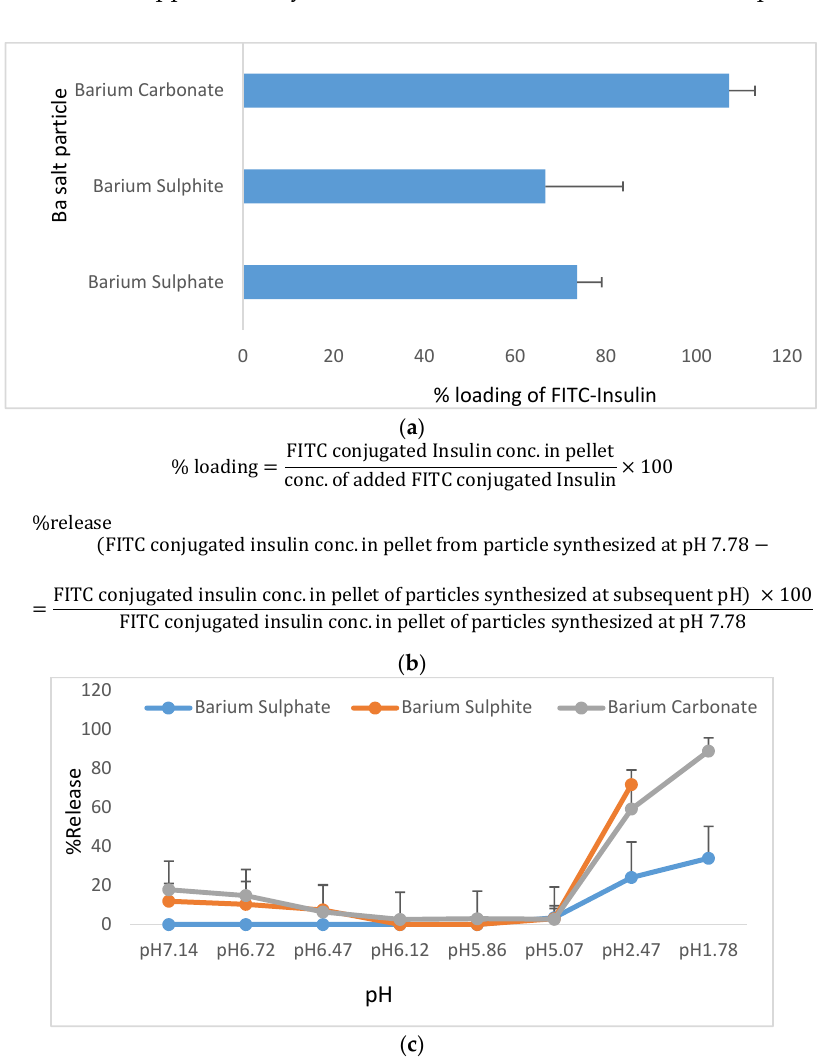
Figure 6. Measurement of insulin binding affinity towards Ba salt particles. The efficiency of FITC-insulin association with the particles (%loading) at pH 7.78 and subsequent release (%release) of FITC-insulin after exposure of the insulin-particle complexes to a range of pHs were calculated from fluorescein intensity of FITC-insulin loaded into Ba salt particle. ( a ) Shows % loading of FITC-insulin into Ba salt particle (BaSO 4 , BaSO 3, and BaCO 3 ). ( b ) Presents the formula for calculation of %loading and %release of insulin, whereas ( c ) demonstrates the data pertaining to % release of FITC-insulin at lower pHs (pH 7.14–pH 1.78).